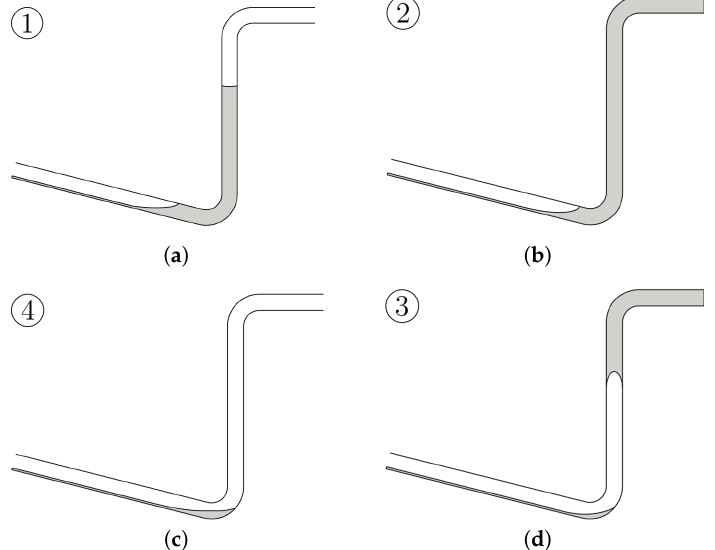
Figure 1. The stages of a riser-induced slug cycle. ( a ) Slug formation; ( b ) Slug production; ( c ) Liquid fallback; ( d )